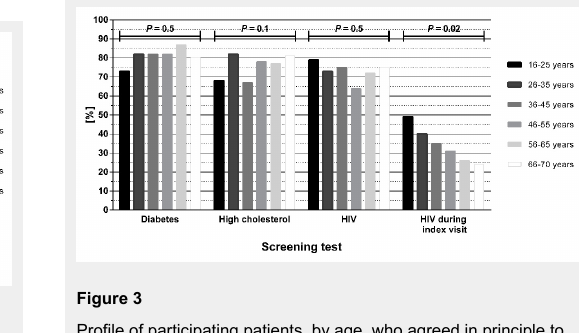
Profile of participating patients, by age, who agreed in principle to non-targeted screening in the emergency department (ED) for diabetes, high cholesterol and human immunodeficiency virus (HIV) and who agreed to be HIV tested during their current ED visit. The p-values are derived from the chi squared test.